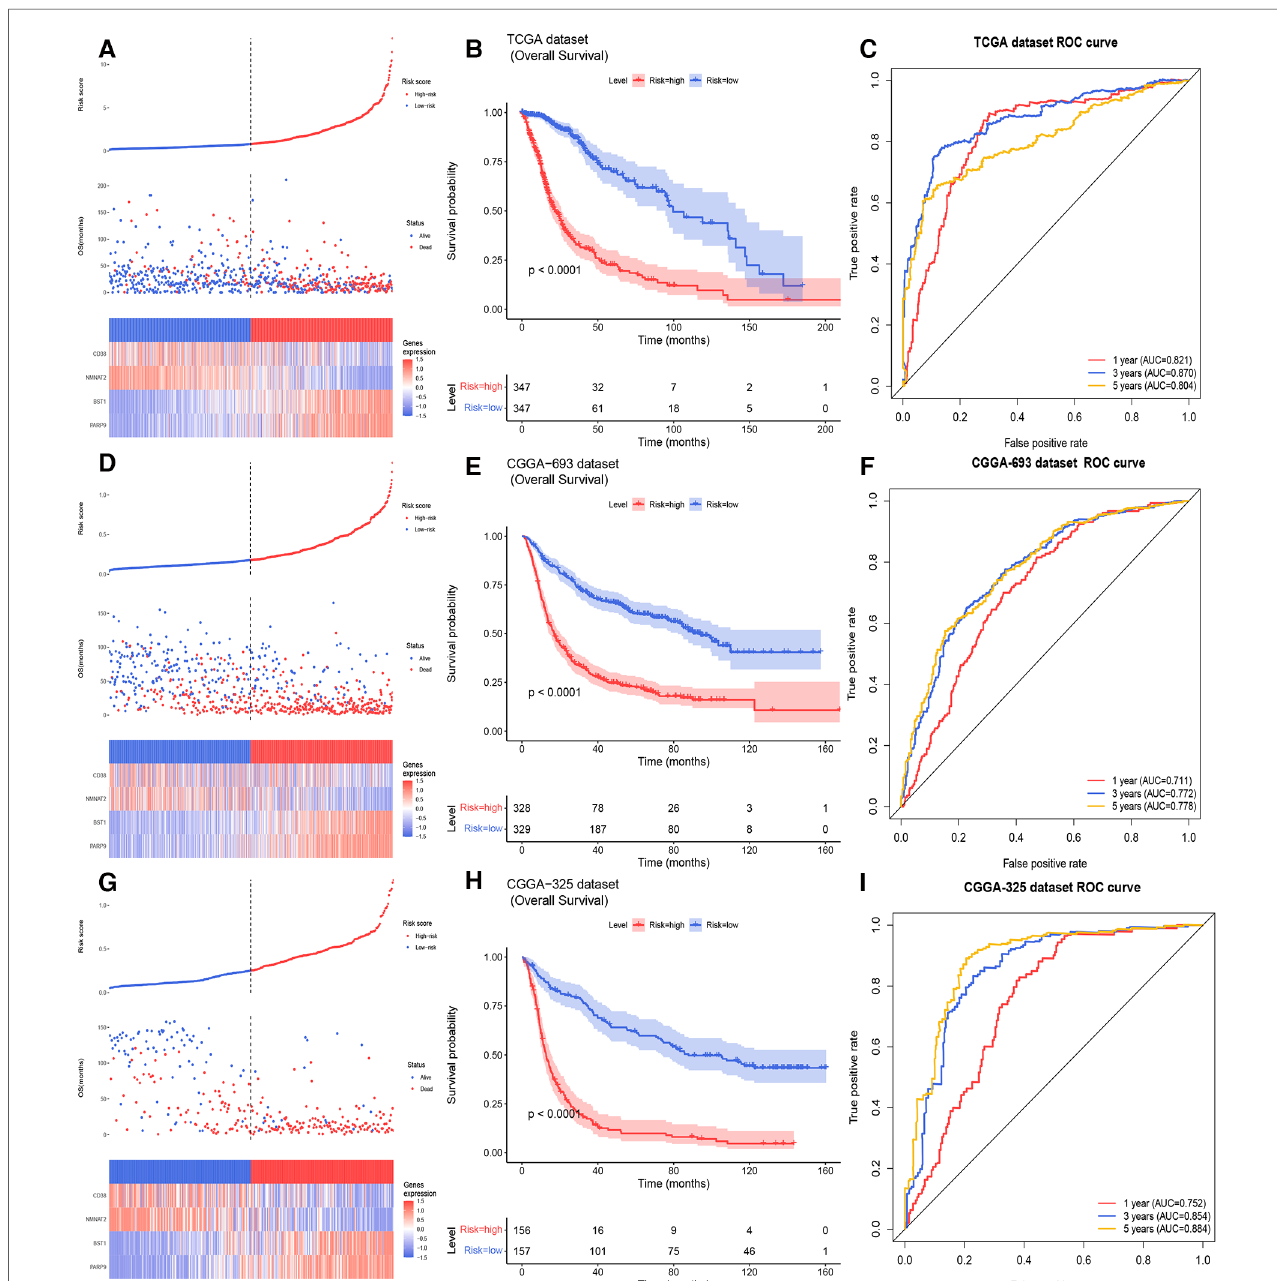
FIGURE 4 Building and validating of a risk model ( A ) the risk curve, scatter diagram, and model gene expression heat map of the training cohort ( B ) survival curves of the high- and low- risk groups of the training cohort. ( C ) The ROC curves of glioma patients in training cohort for 1, 3, 5 years ( D ) the risk curve, scatter diagram and model gene expression heat map of the CGGA 693 cohort. ( E ) Survival curves demonstrating that glioma cases in the high- and low- risk groups of the CGGA 693 cohort. ( F ) The ROC curves of glioma patients in the CGGA 693 cohort. ( G ) The risk curve, scatter diagram, and model gene expression heat map of the CGGA 325 cohort. ( H ) Survival curves for glioma cases of the CGGA 325 cohort in the two risk groups. ( I ) The ROC curves of glioma patients in CGGA 325